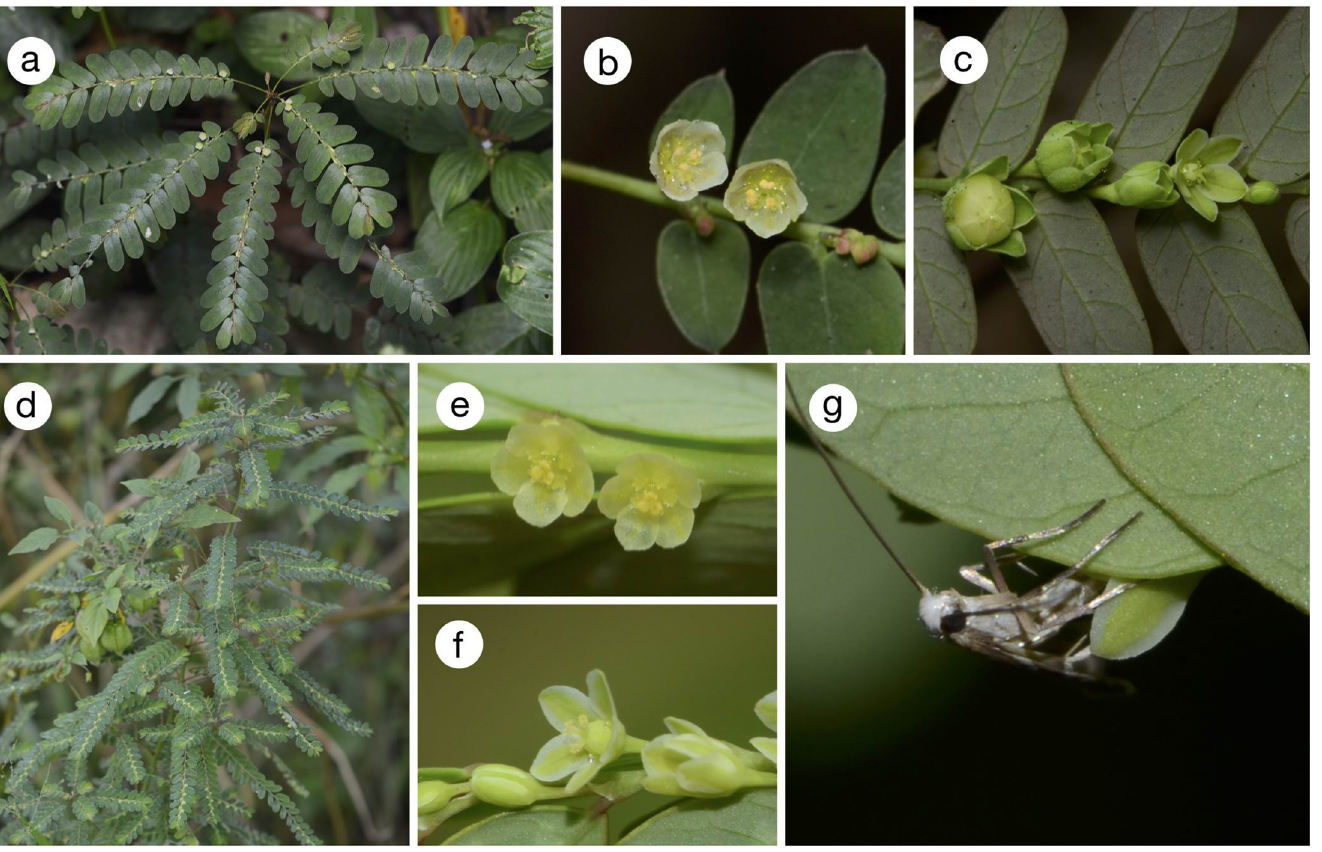
Fig 5. Phyllanthus stipulatus , P . amarus , and associated Epicephala . (a)–(c) P . stipulatus ; (d)–(g) P . amarus . (a) Habit; (b) male flowers; (c) female flower and young fruits; (d) habit; (e) male flowers; (f) female flower; (g) Epicephala chancapiedra female ovipositing in young fruit.